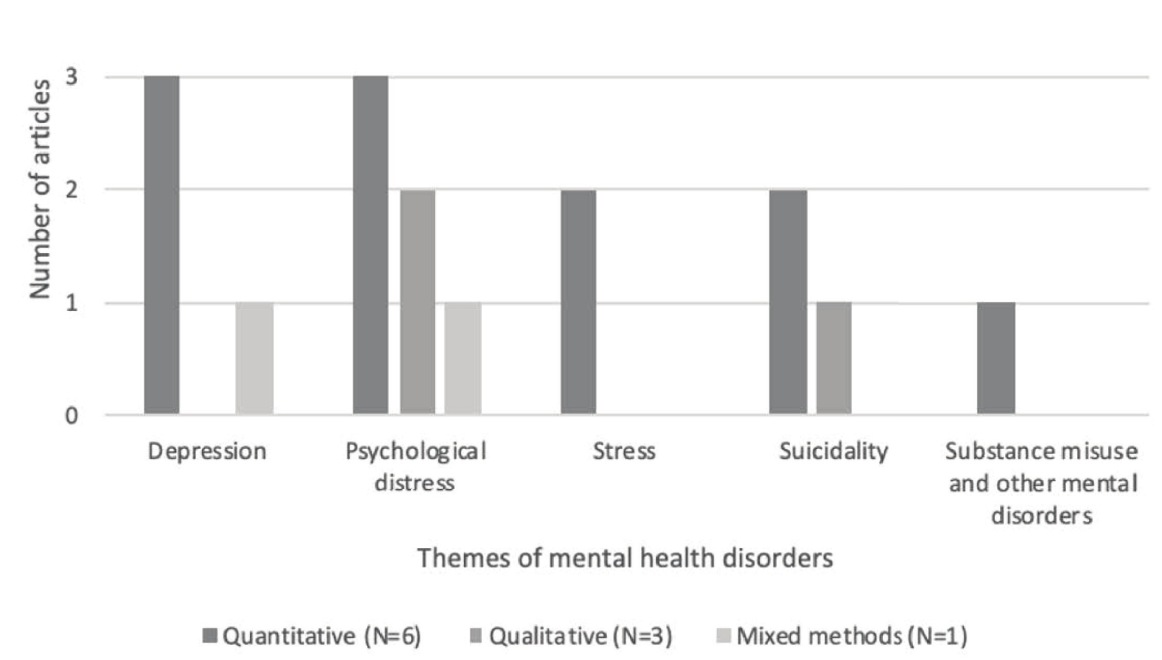
Fig 3. Thematic areas describing mental health disorders and factors identified in our review.